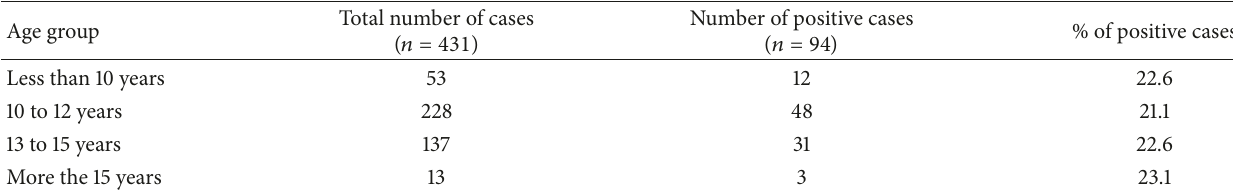
Table 2: Distribution of H. pylori infection among school-aged children according to their age groups at Kassala city,